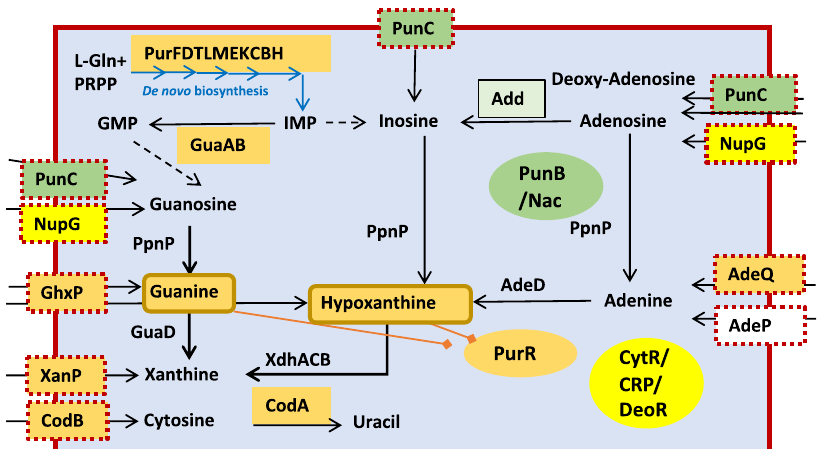
Fig. 1 Metabolic pathways and transcriptional regulons for purine biosynthesis and purine/pyrimidine uptake and salvage genes in E. coli . The de novo purine biosynthesis pathway is illustrated with blue arrows. Other enzymes involved in purine and pyrimidine metabolism are shown with black arrows. Nucleoside uptake transporters are shown having dashed boxes. PurR is a transcriptional repressor of most of the purine biosynthesis and salvage genes in response to hypoxanthine and guanine. The PurR-regulated genes are highlighted in orange. The purine uptake transporter NupG is under transcriptional control of CytR, DeoR and CRP (shown in yellow). The purine transporter PunC (YdhC), described in this study, is controlled by the LysR-family activator PunR (YdhB) and Nac, as highlighted in green. Abbreviations: IMP, inosine monophosphate; AMP, adenosine monophosphate; GMP, guanosine